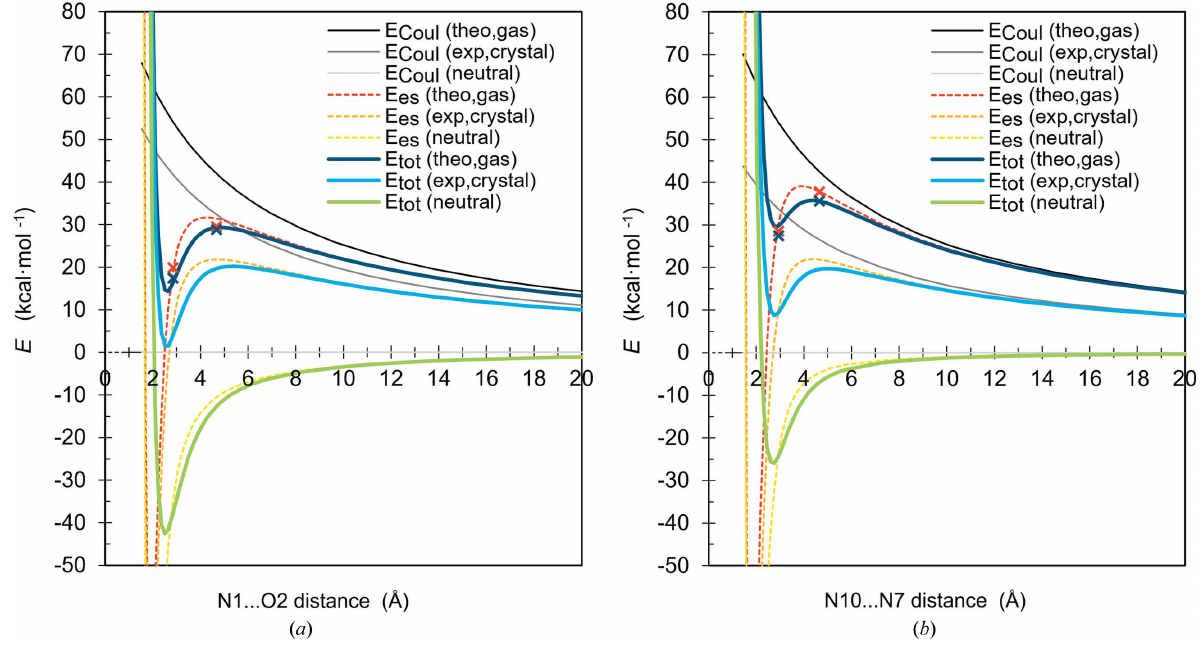
Figure 10 Total interaction energies E tot (kcal mol (cid:4) 1 ), electrostatic contributions E es (kcal mol (cid:4) 1 ) to total interaction energies, and electrostatic energies computed from point molecular charges E Coul (kcal mol (cid:4) 1 ) for the AA1 dimers extracted from ( a ) the CC and ( b ) the ACH experimental crystal structures as a function of donor (cid:7)(cid:7)(cid:7) acceptor distance (A ˚ ), simulating the dissociation curve along hydrogen bonding. E tot (theo,gas) and E es (theo,gas) are the energies according to the DFT-SAPT method applied to dimers of molecules bearing formal +1 e charge; E tot (exp,crystal) and E es (exp,crystal) are the energies from DFT-SAPTafter rough correction taking into account the partial molecular charge observed from experiment; E tot (neutral) and E es (neutral) are the energies from DFT-SAPT after complete removal of electrostatic repulsion due to the presence of molecular charge; and E Coul are the energies computed from various point molecular charges placed at the centres of molecular mass: +1 e (theo,gas), experimental charge (exp,crystal), 0 e (neutral). Dark-blue and red crosses denote E tot (theo,gas) and E es (theo,gas) DFT-SAPT energies, respectively, computed for geometries taken from dimer geometry optimization and transition state search in the gas